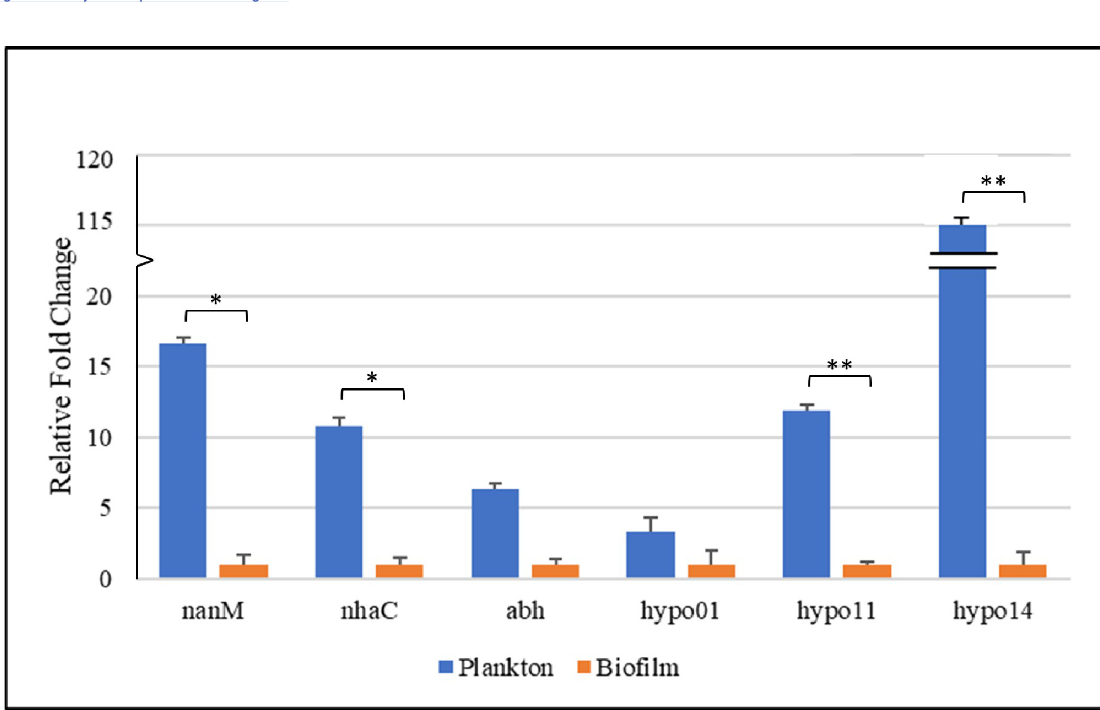
Fig 4. Comparison of expression of nanM , nhaC , hypo01 , abh , hypo11 , and hypo14 during planktonic growth and mature biofilm phases. APEC O18 was grown until the exponential phase of growth in M63 minimal medium at 37˚C to measure the expression of the planktonic cells. APEC O18 was grown statically for 24 h in M63 minimal medium at 37˚C to form the mature biofilm. RNA from each phase of growth was extracted, purified, then reverse-transcribed into cDNA to read the expression of each gene. Expression was averaged among technical and biological triplicates and measured in fold change using the Livak method ( � p < 0.01, �� p < 0.001).